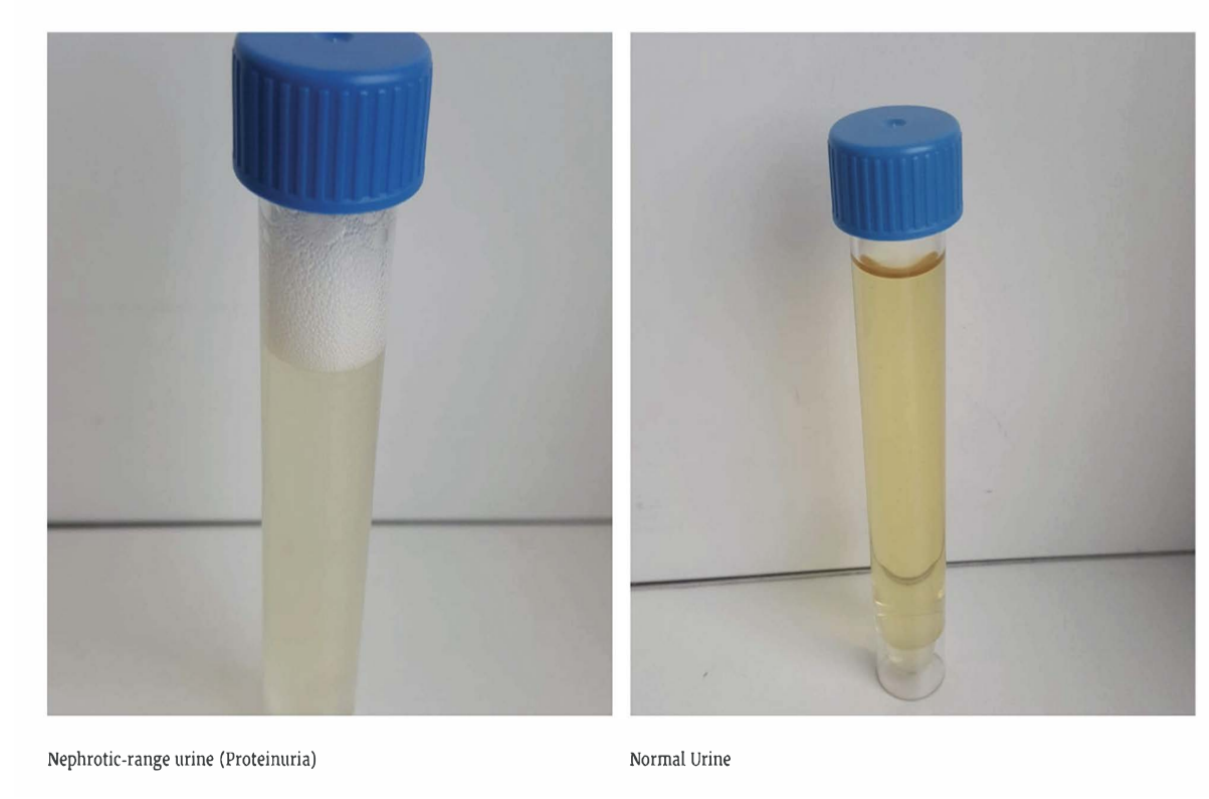
Figure 2. An example of the use of rich media in the e-learning activity.